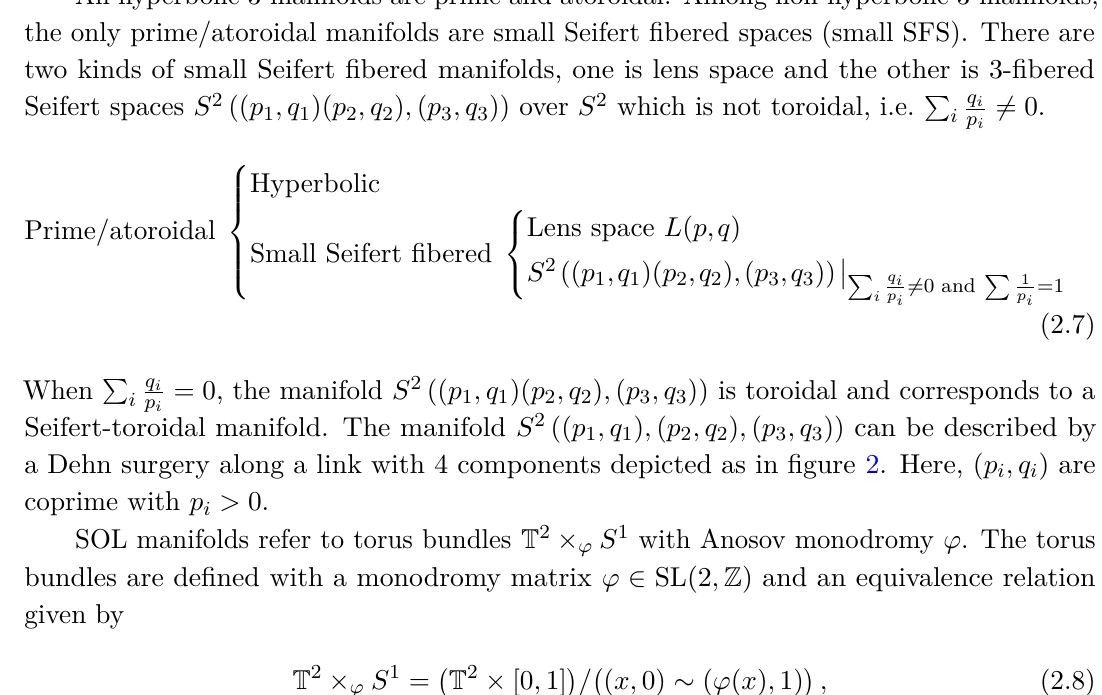
sum of two manifolds neither of which is a 3-sphere S 3 . 1 Depending on the existence of the essential torus, 3-manifolds can further be divided into two classes: toroidal (if exists) or